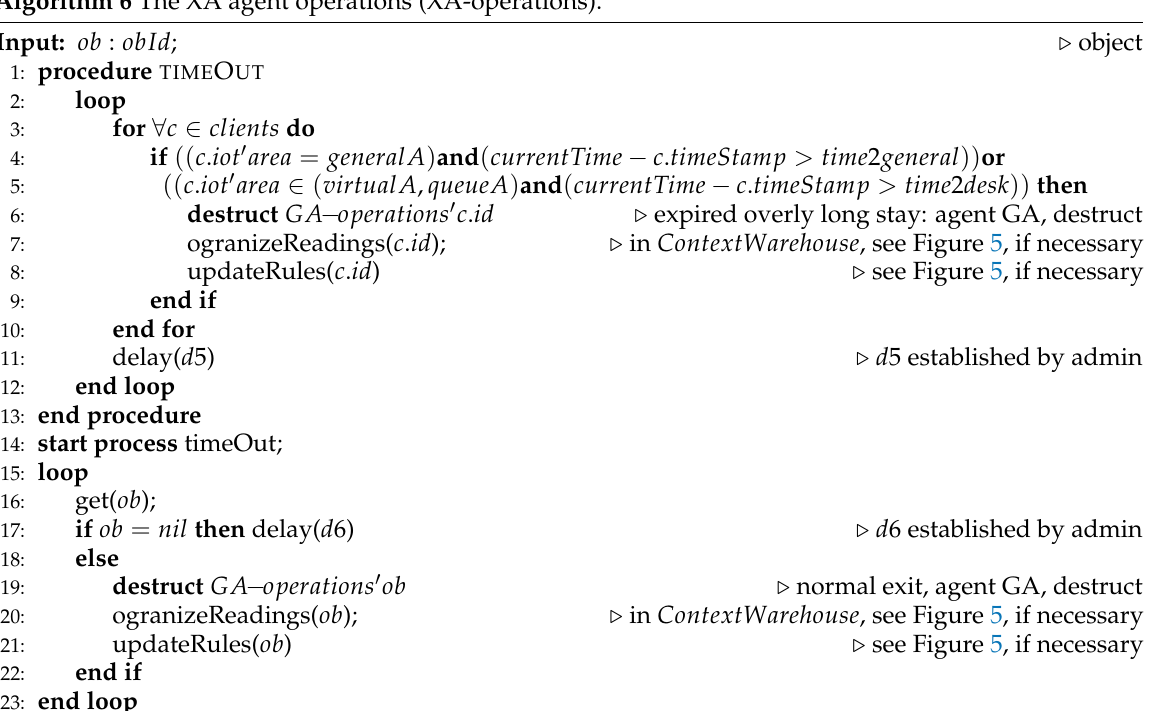
Algorithm 6 The XA agent operations